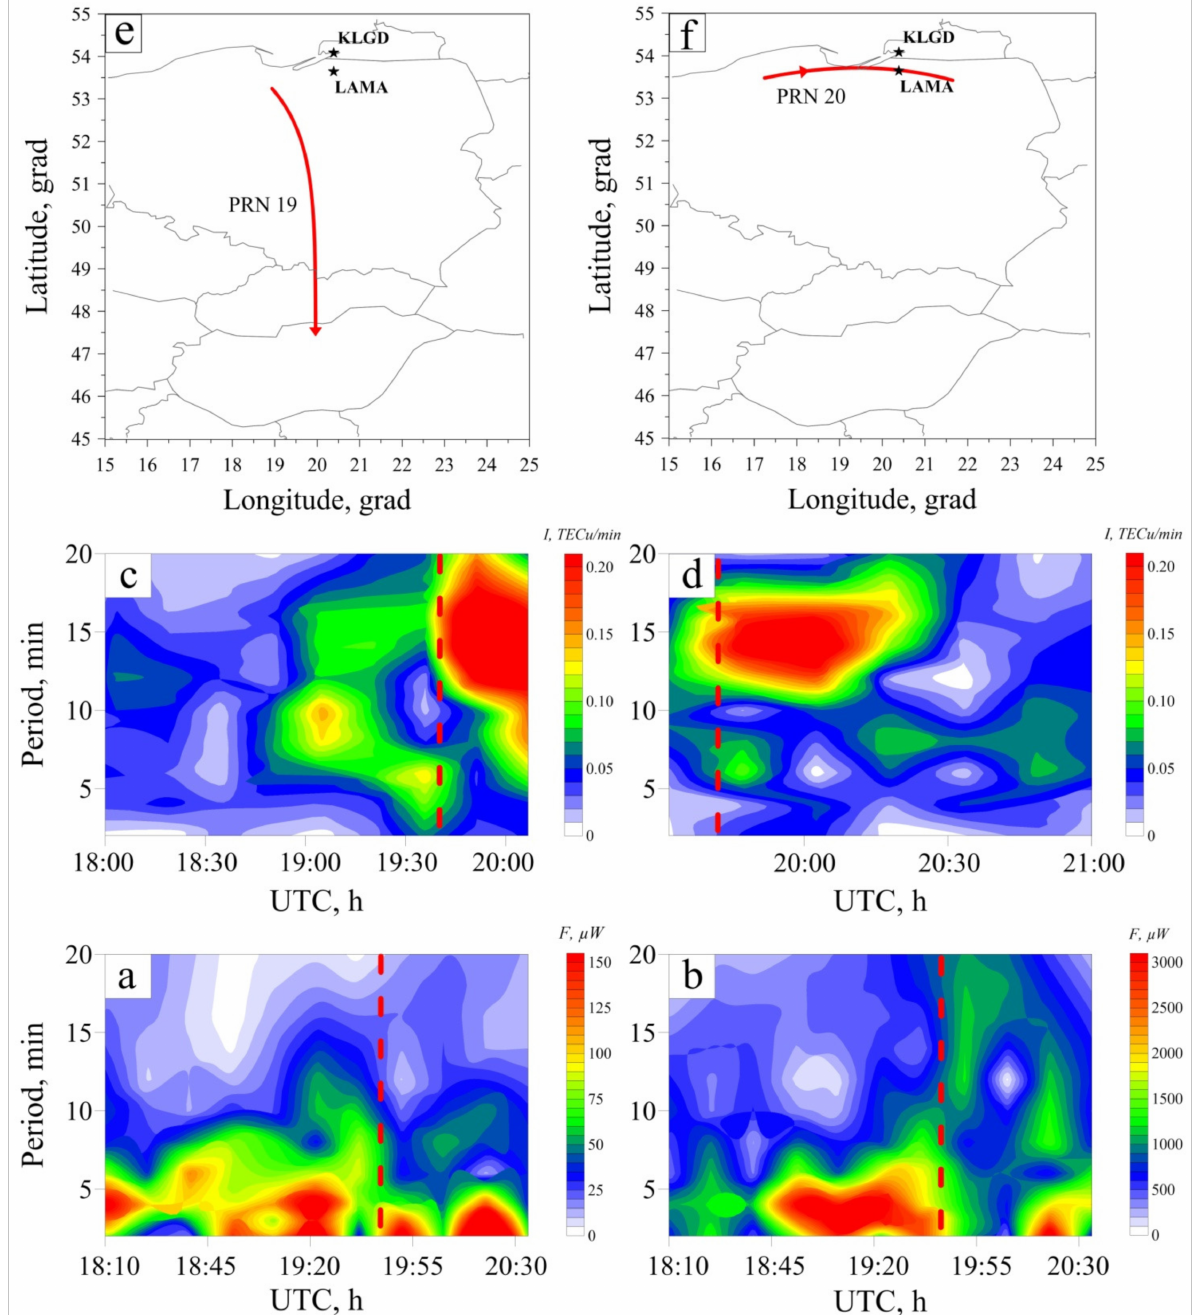
Figure 4. Spectra of variations of the troposphere (bottom row) and ionosphere (middle row) parameters during the passage of the evening solar terminator on 28 August 2012. Lidar measurements were carried out by the KLGD station at wavelengths: ( a ) λ 1 = 1064 nm; ( b ) λ 2 = 532 nm. Propagation beam length is L m = 6000 m. Satellite GPS measurements were performed at the mid-latitude station LAMA: ( c ) PRN 19; ( d ) PRN 20. Projections of satellite trajectories corresponding to the time scale of satellite measurements are: ( e ) PRN 19; ( f ) PRN 20. The arrows indicate the direction of satellite movement. The terminator transit time corresponds to 19:40 UTC and is indicated by a red dotted